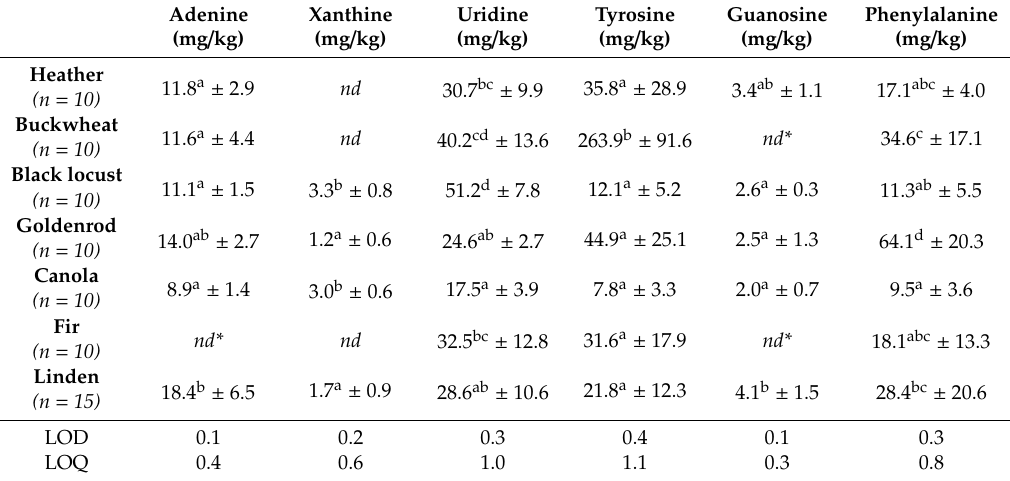
Table 2. Amounts of the identified nitrogen compounds in varietal honey